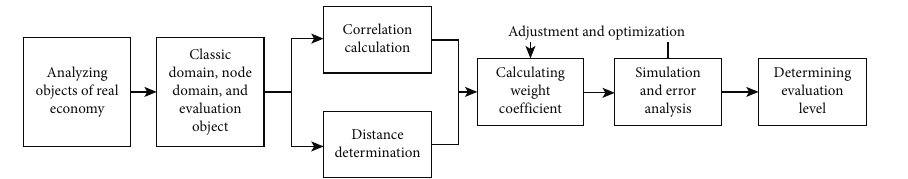
Figure 1: Workflow of